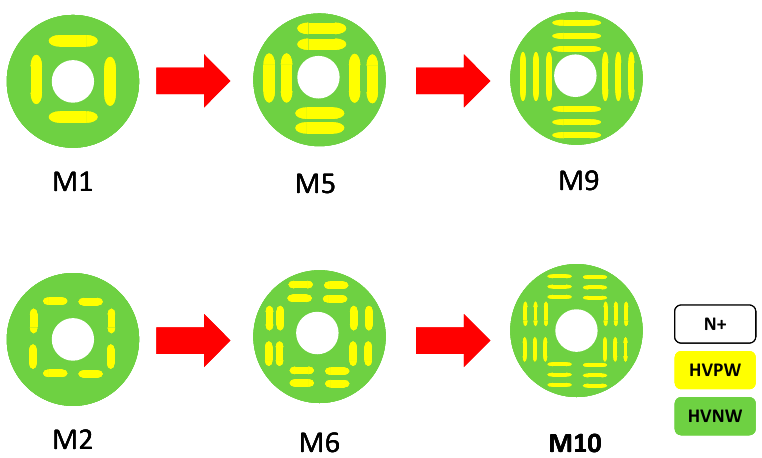
Figure 6. Device layout diagrams of six UHV 300 V LDMOSs with symmetrical four-zone SJs in the drain region.